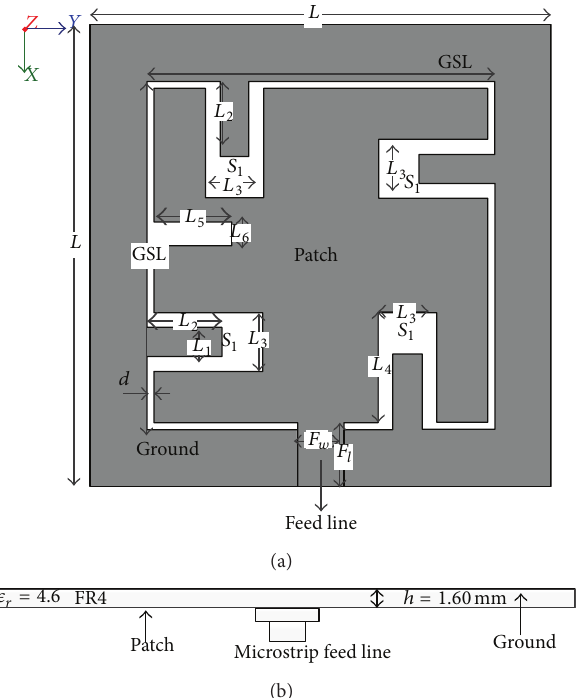
Figure 1: Proposed antenna geometry. (a) Front view. (b) Cross- sectional view.